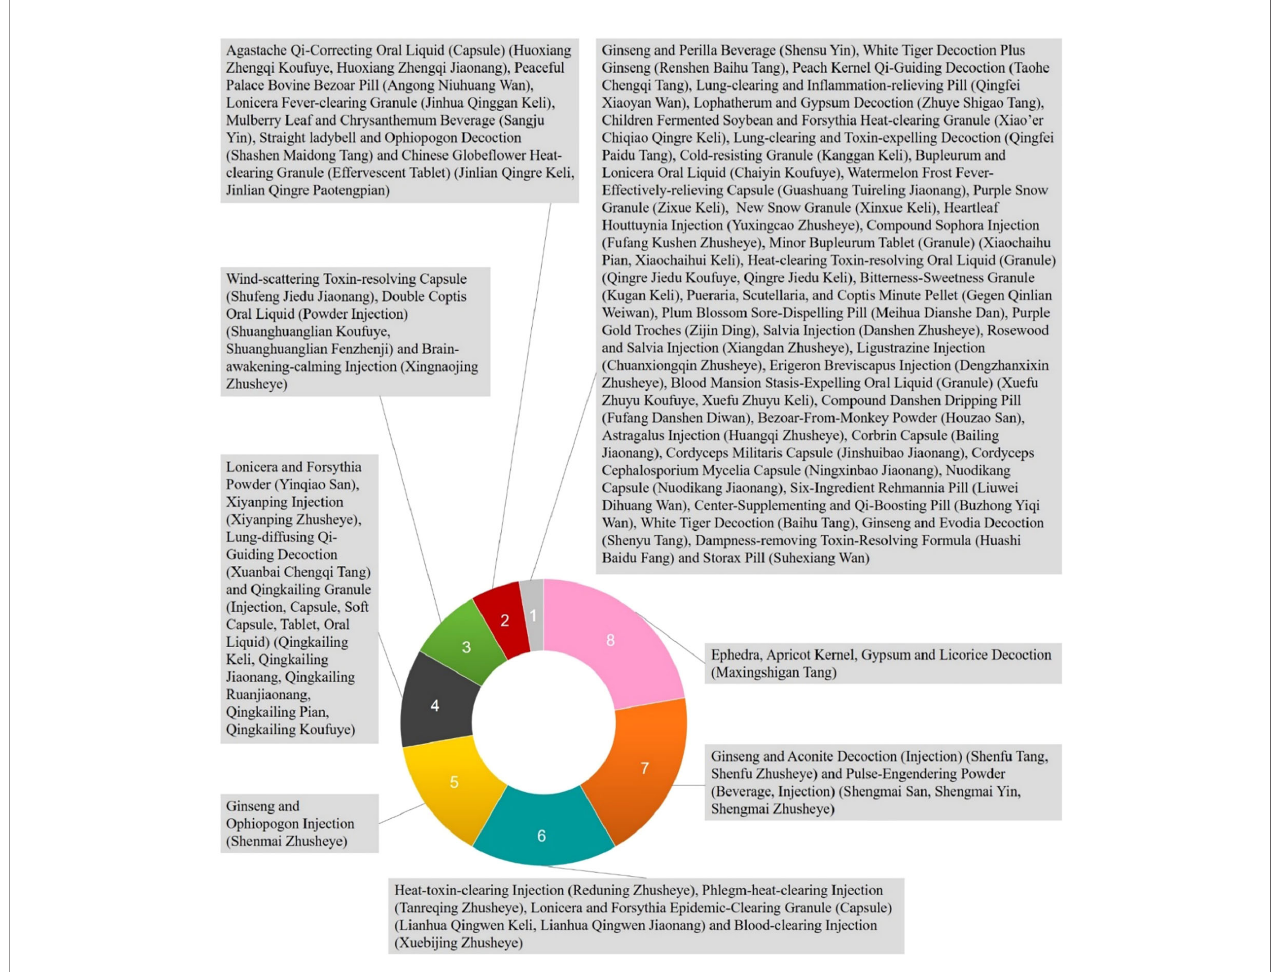
FIGURE 2 | Usage frequency of Chinese medical formulas and proprietary traditional Chinese medicine products in traditional Chinese medicine (TCM) part of the China National Guidelines of Diagnosis and Treatment for SARS-CoV, MERS-CoV, SARS-CoV-2, and in fl uenza virus (The statistical data were based on the analysis of Chinese medical formulas and proprietary traditional Chinese medicine products involved in different syndromes of viral pneumonia in China ’ s National Guidelines for TCM treatment of SARS-CoV, MERS-CoV, SARS-CoV-2, and in fl uenza